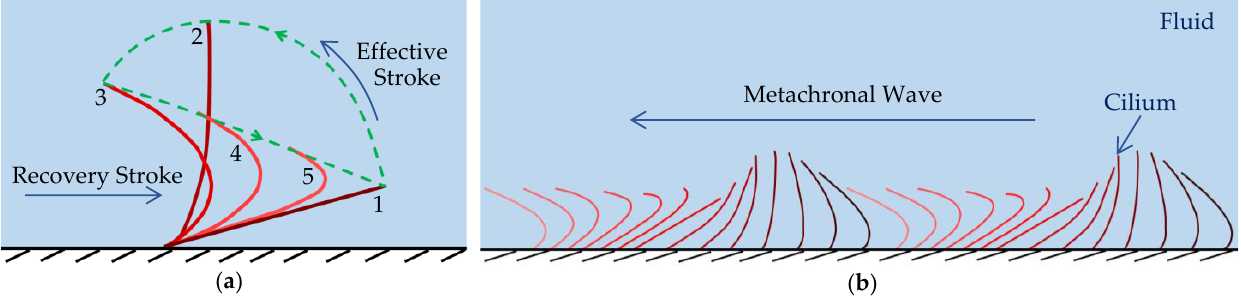
Figure 5. Cilium motion: ( a ) Effective and recovery stroke of a cilium; ( b ) metachronal wave generated by an array of cilia.